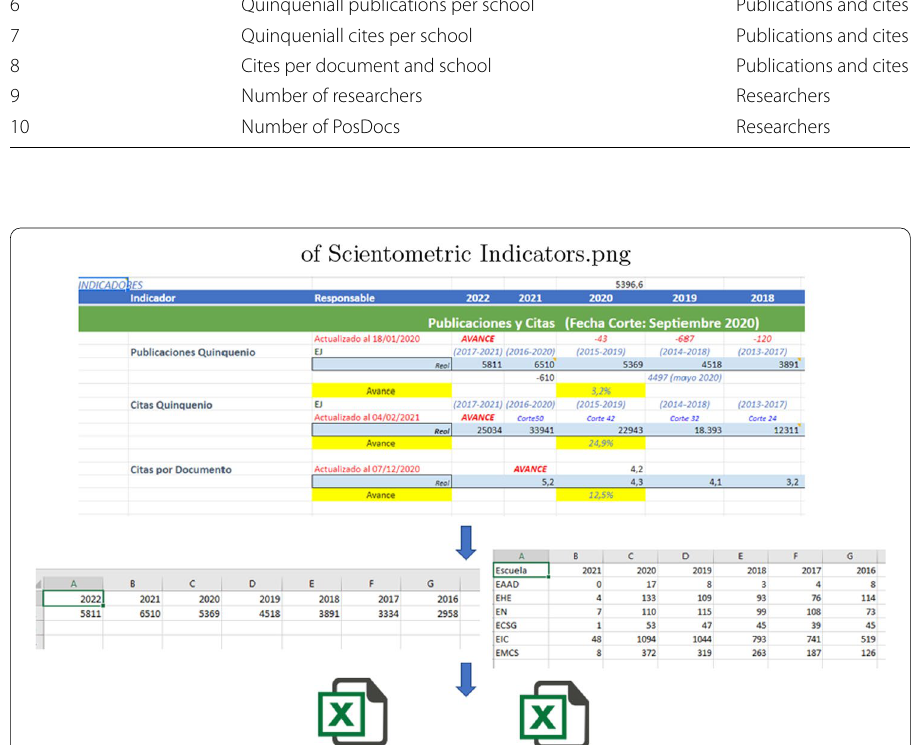
Fig. 2 Extraction of scientometric